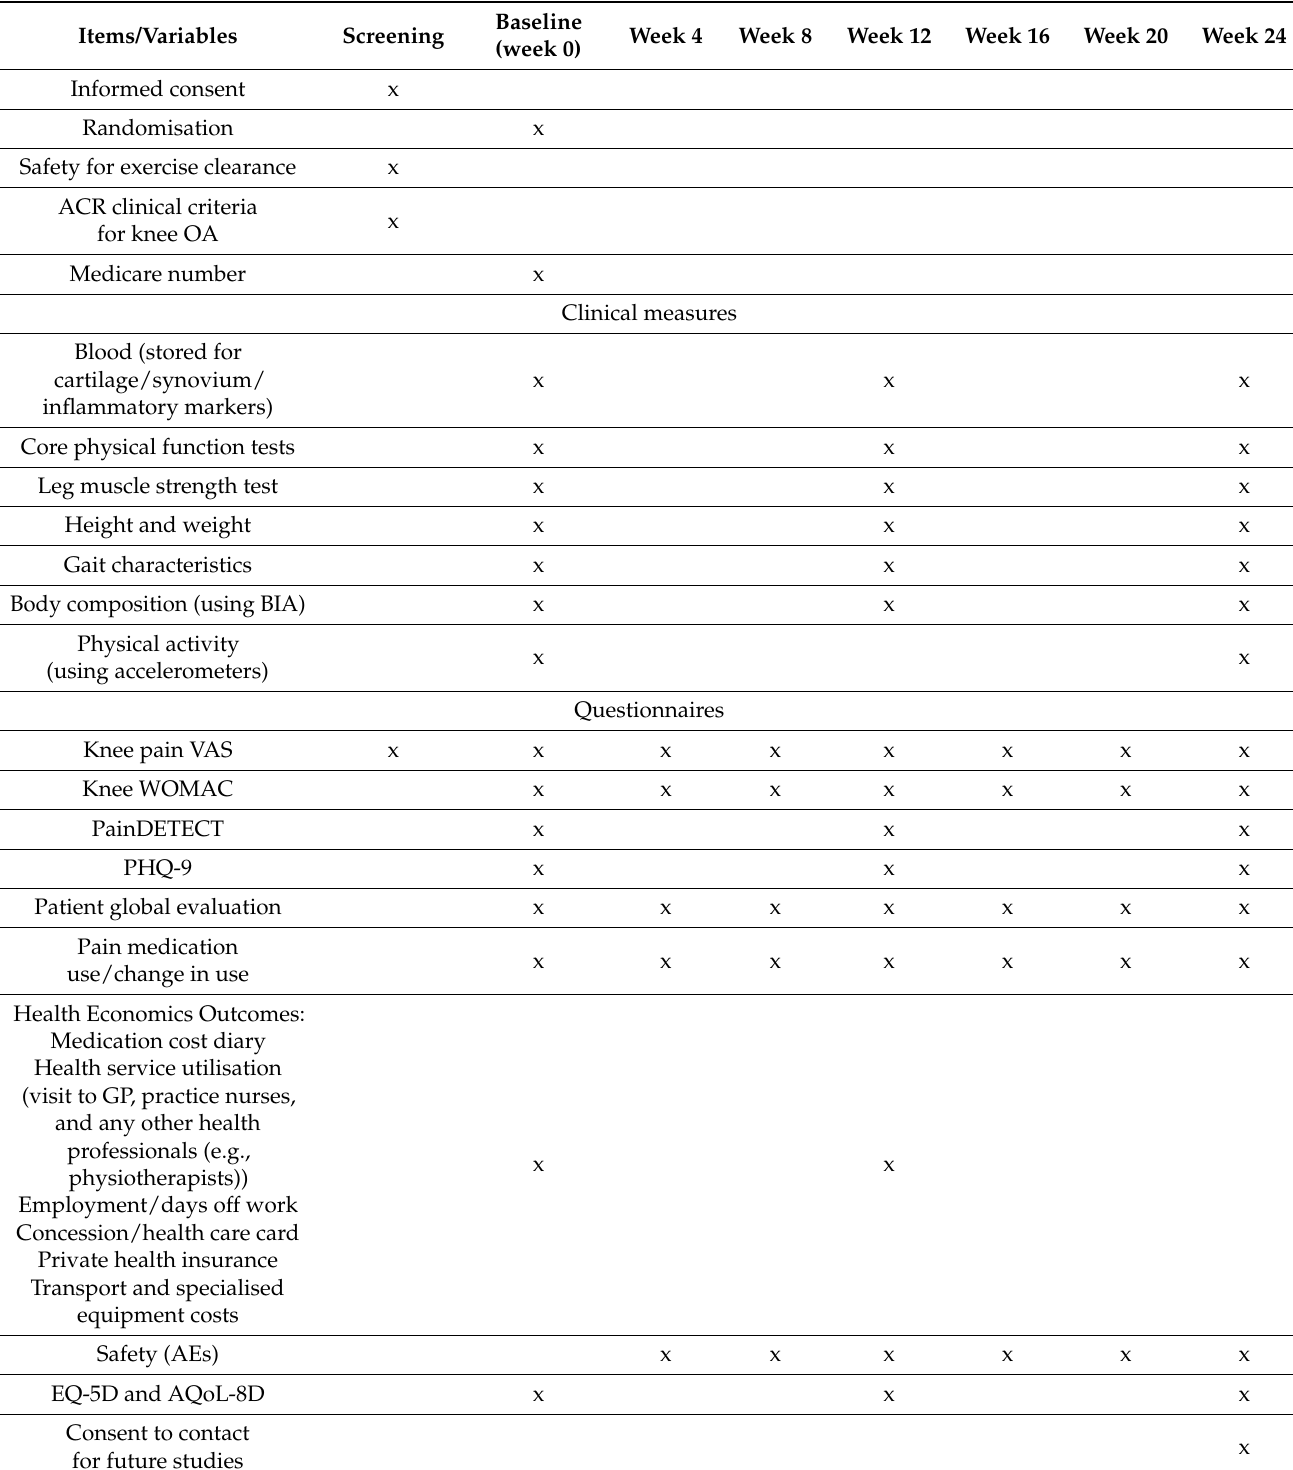
Table 1. SPIRIT (Standard Protocol Items: Recommendations for Interventional Trials) diagram of enrolment, interventions, and assessments for the YOGA